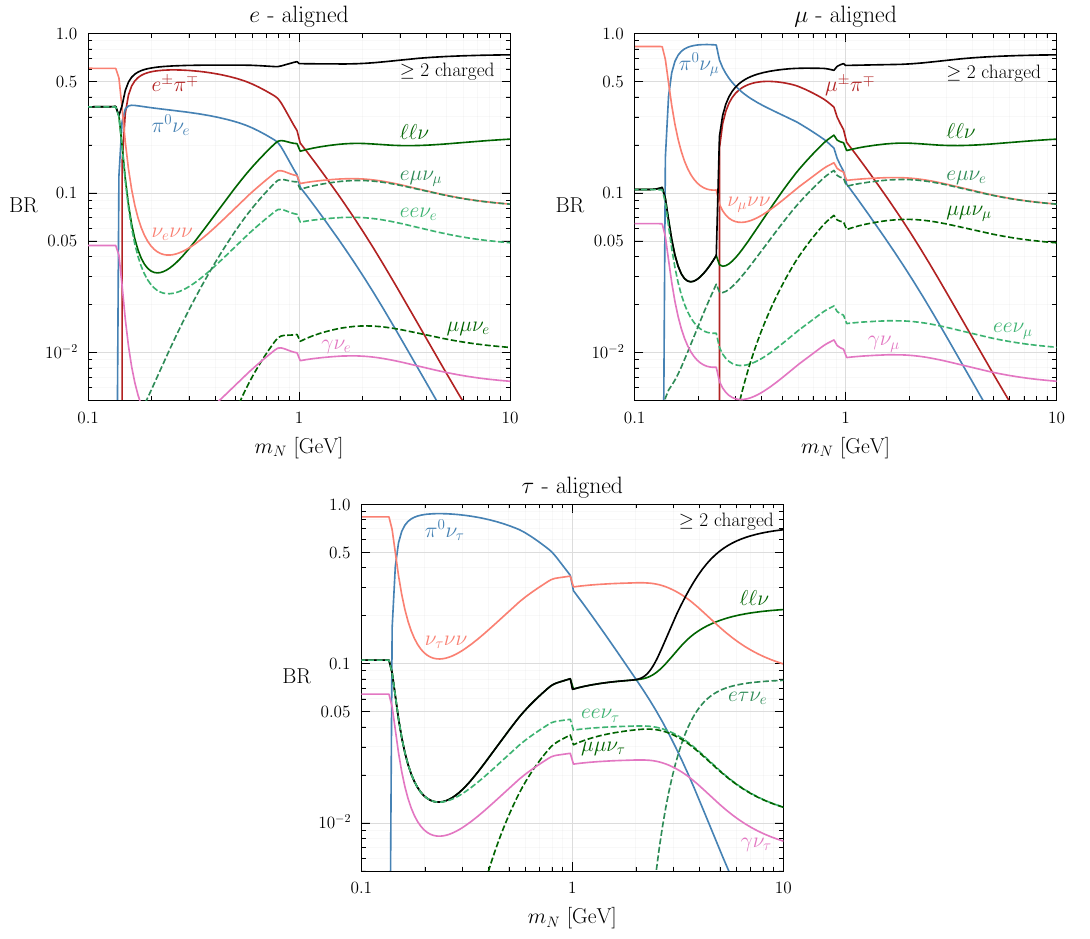
Figure 3 . Branching ratios of an electron-mixed (left upper panel), muon-mixed (right upper panel), and τ -mixed (lower panel) HNL into different final states as a function of the HNL mass, m N . The thick black curve represents the sum of the branching ratios into two or more charged particles in the final state, while the solid green curve labeled ‘‘ν is the sum of the branching ratios into charged lepton final